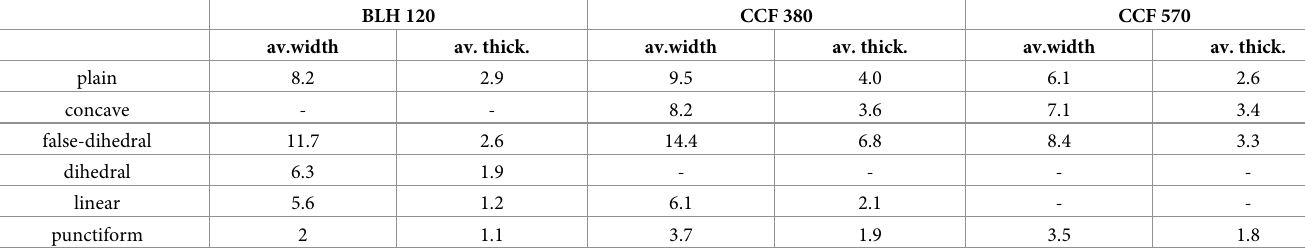
Table 4. Average width and thickness dimensions by type of butt per house.